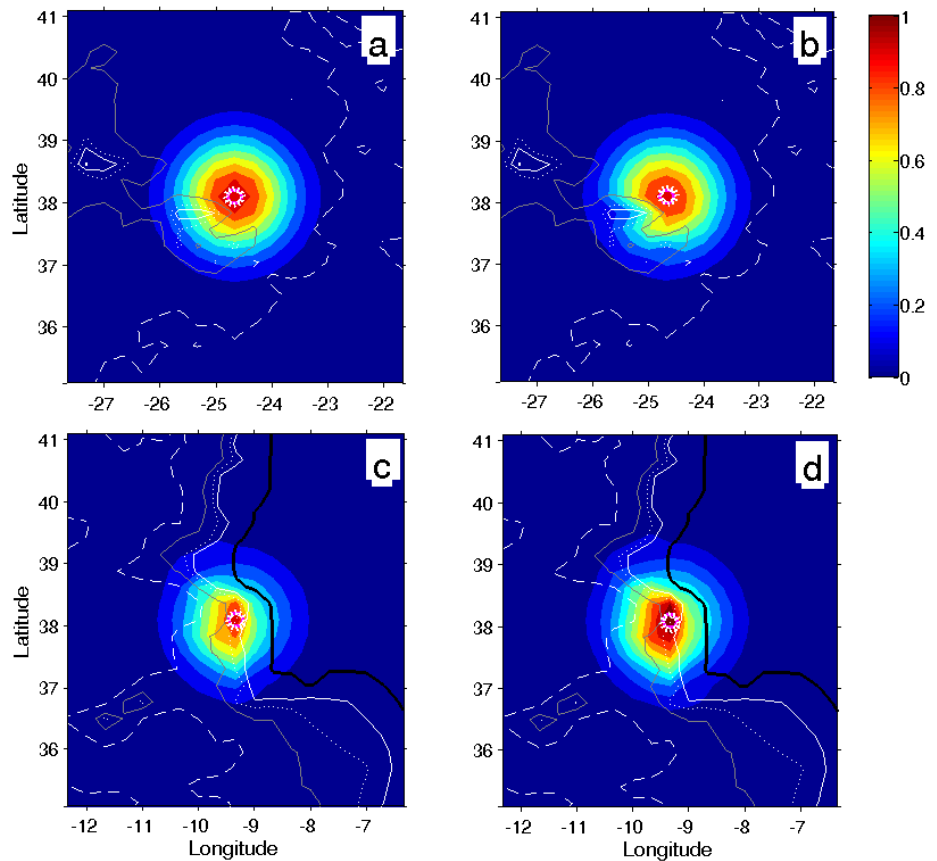
Figure 2. Weight function ( W) for (a) the small effect of topography for h = 100m, (b) the stronger effect at the same location for h = 1500m and (c–d) the dominating effect of topography near the continental slope for h = 100m. Lower panels show the shape of the weight function (c) when the correction factor w is not applied, and (d) with the correction factor w applied. The color scale marks the distribution of the weights as a function of the distance from the central grid point (marked with the white ring). Topographic contours of 0, 500, 1000, 2000, 3000 and 4000m are presented for